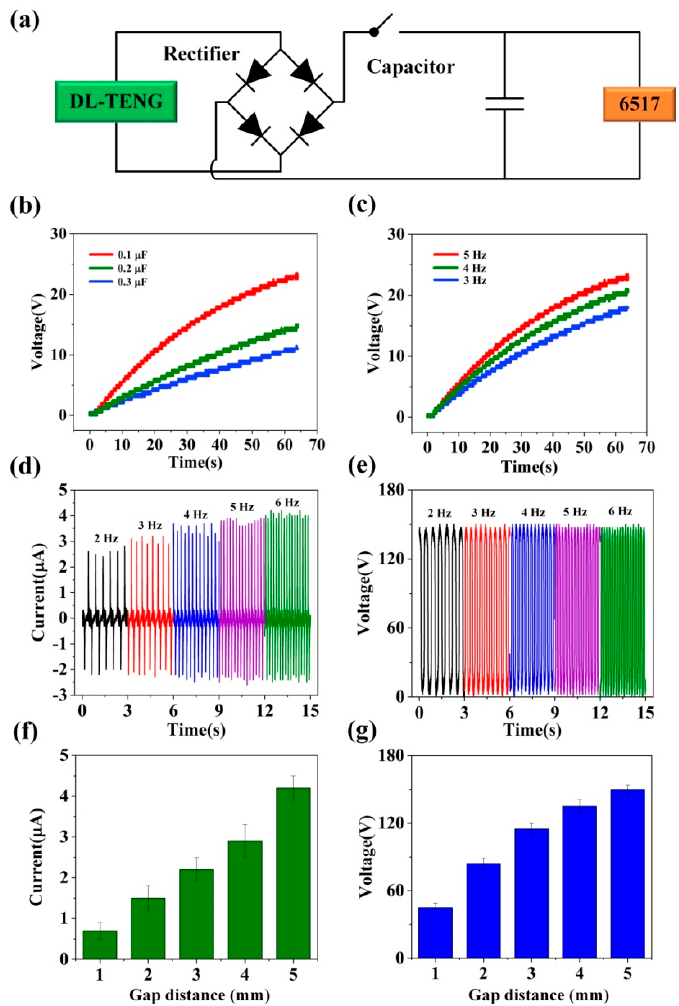
Figure 5. ( a ) The schematic diagram of power management circuit based on the DL-TENG. ( b ) The charging curve of DL-TENG for different capacitors under the working frequency of 5 Hz. ( c ) The charging curve of DL-TENG for 0.1 µF capacitor under different working frequencies. The ( d ) I sc and ( e ) V oc of DL-TENG under different working frequencies. The ( f ) I sc and ( g ) V oc of DL-TENG under different gap distances.